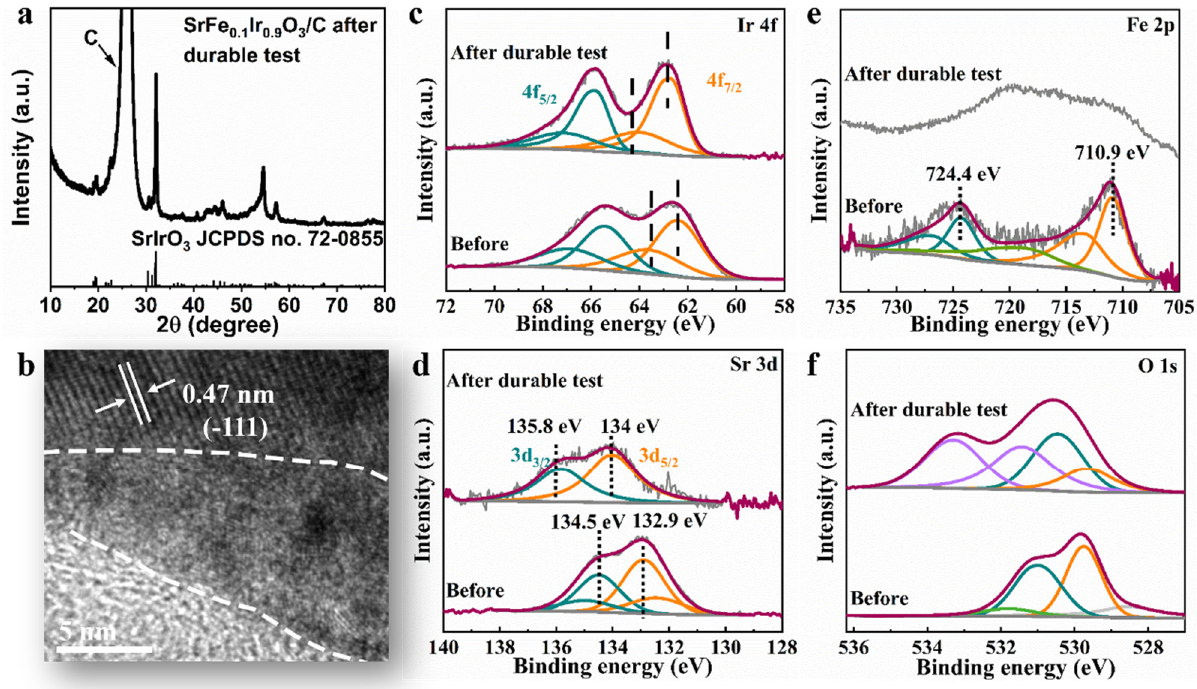
Figure 4. ( a ) XRD pattern of SrFe 0.1 Ir 0.9 O 3 /C after a 10 h durability test, ( b ) HRTEM image of SrFe 0.1 Ir 0.9 O 3 after a 10 h durability test. ( c ) Ir 4f, ( d ) Sr 3d, ( e ) Fe 2p, and ( f ) O 2p XPS spectra of